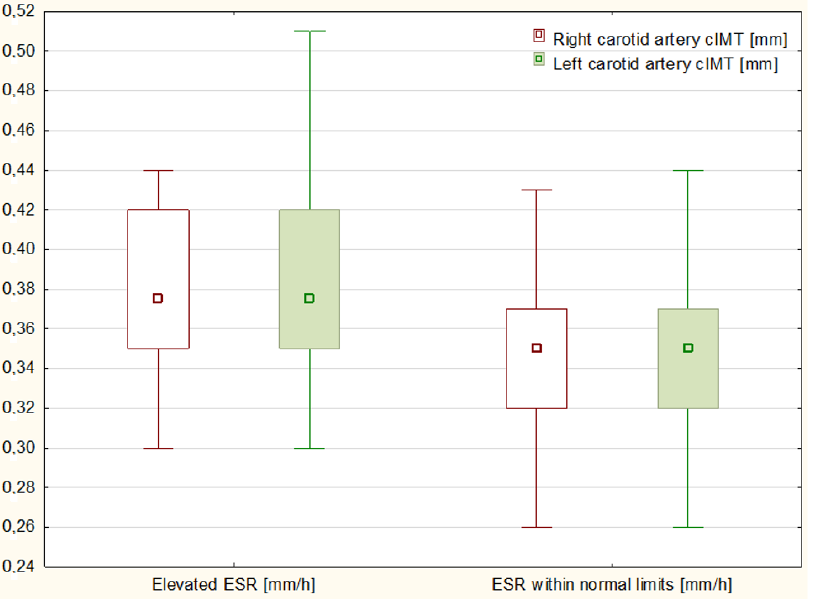
Figure 1. Comparison of carotid intima ‐ media thickness (cIMT) between patients with elevated (left) and normal (right) erythrocytes sedimentation rate (ESR).